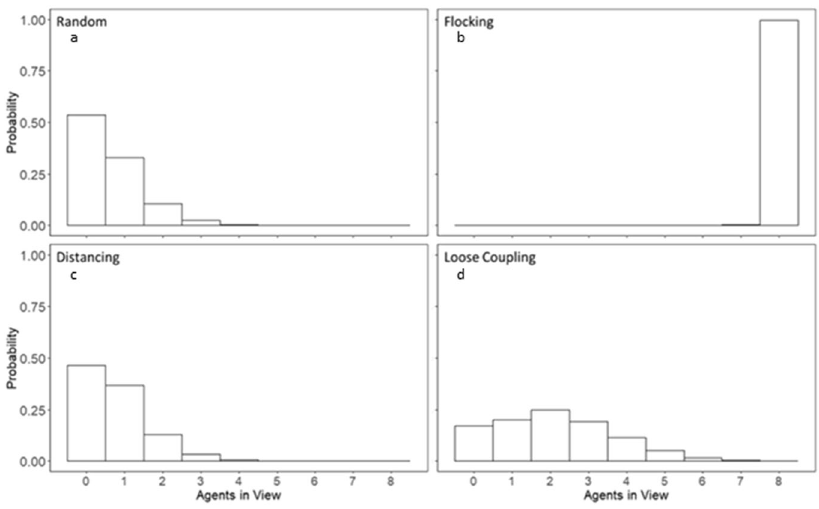
Figure 5. Normalized histogram of the number of agents in view during the search time period respective to one autonomous agent without intervention.